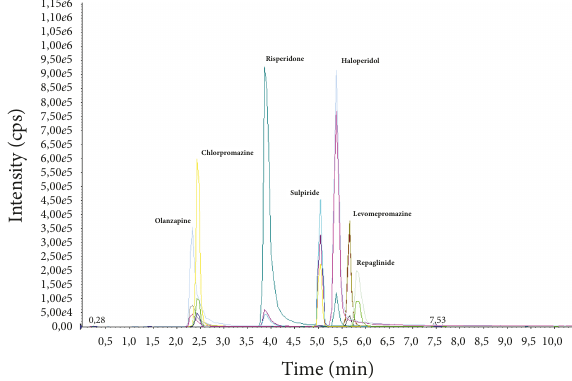
Figure 1: MRM chromatogram of blank plasma sample spiked with antipsychotics (chlorpromazine, haloperidol, levomepromazine, olanzapine, risperidone, and sulpiride) at concentration of 75, 40, 100, 100, 100, and 80 ng/ml,